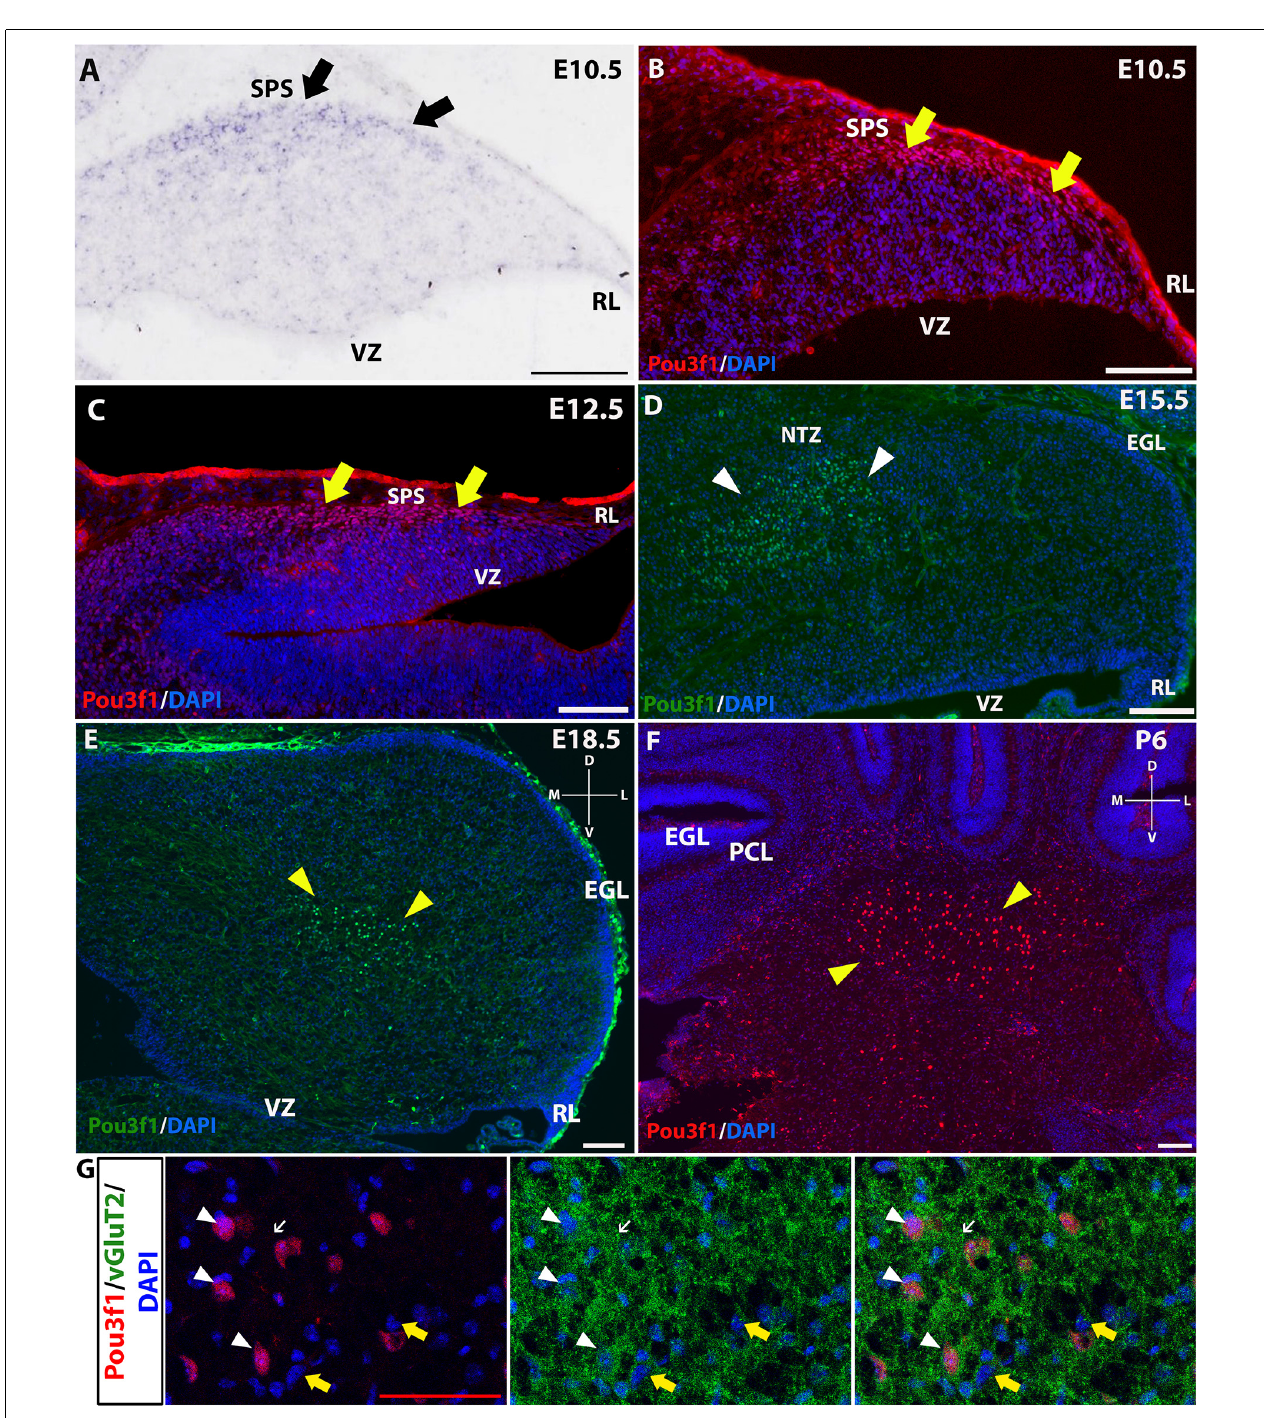
FIGURE 2 | The expression pattern of Pou3f1 across space and time. (A–C) In the E10.5 and E12.5 cerebella, in situ hybridization (ISH) (A) and immunofluorescent (IF) staining (B,C) reveal that Pou3f1 is expressed in cells along the subpial stream (SPS, arrows). (D) In the E15.5 cerebellum, Pou3f1 is expressed primarily in the nuclear transitory zone (NTZ, white arrowheads). (E,F) By E18.5, Pou3f1-expressing cells have reached the cerebellar white matter (yellow arrowheads), and continue to populate the cerebellar white matter at P6 (yellow arrowheads). (G) In the P6 cerebellum, Pou3f1 + cells co-express vGluT2 (white arrowheads). vGluT2 proteins in the cerebellar white matter are localized to the cell bodies (white arrowheads) and the synaptic boutons (white arrows). vGluT2 - cells are also found in the cerebellar white matter (yellow arrows). Panels (A–D) show sagittal sections of the cerebellum, while sections shown in (E–G) are in the coronal plane. D, dorsal; EGL, external germinal layer; L, lateral; M, medial; NTZ, nuclear transitory zone; PCL, Purkinje cell layer; RL, rhombic lip; SPS, subpial stream; V, ventral; VZ, ventricular zone. White scale bars, 100 µ m. Red scale bar, 50 µ m.